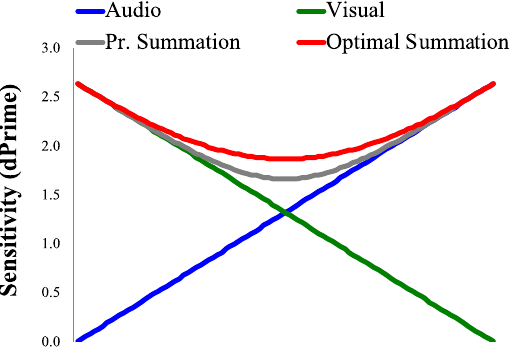
Figure 1. Plots of inversely varying simulated audio (blue) and visual (red) sensitivity scores, in addition to sensitivity scores predicted by weighted summations of unimodal signals (red) and via probability summations (grey). Note that the largest difference, between unimodal sensitivities and predicted bimodal sensitivities, occurs when unimodal sensitivities are precisely